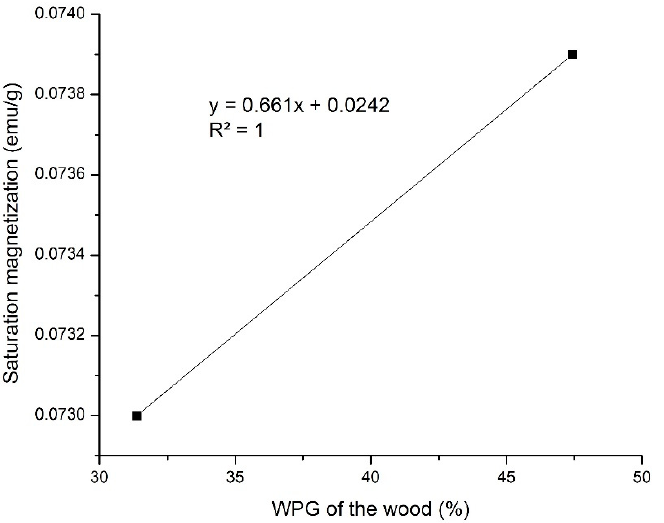
Figure 6. Correlation between weight percent gain (WPG) and saturation magnetisation (Ms) of treated jabon treated jabon wood. Table 3. The saturation magnetisation (M s ), coercivity (H c ), and retentivity (M r ) of the treated jabon wood.